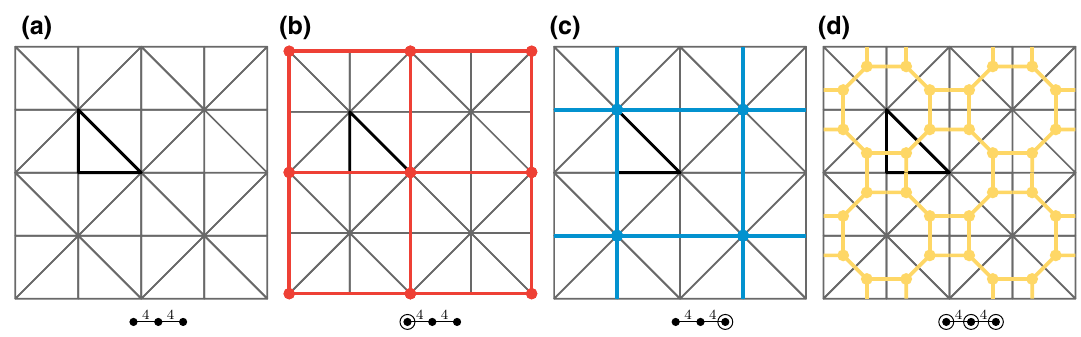
FIG. 14. Examples of Wythoff’s construction applied to the Coxeter diagram 44 . (a) The Coxeter kaleidoscope described in Fig. 13. The fundamental region is highlighted in black. (b) Ringing the first vertex of the Coxeter diagram corresponds to placing the generating point at one of the corners of the fundamental region (red circle). The resultant tessellation is a square tiling. (c) By symmetry, ringing the third vertex of the diagram also leads to a square tiling. (d) Ringing all three vertices of the Coxeter diagram corresponds to placing the generating vertex at the center of the fundamental region (equidistant from each reflecting hyperplane). In the resultant tessellation, two octahedra and one square meet at each vertex.